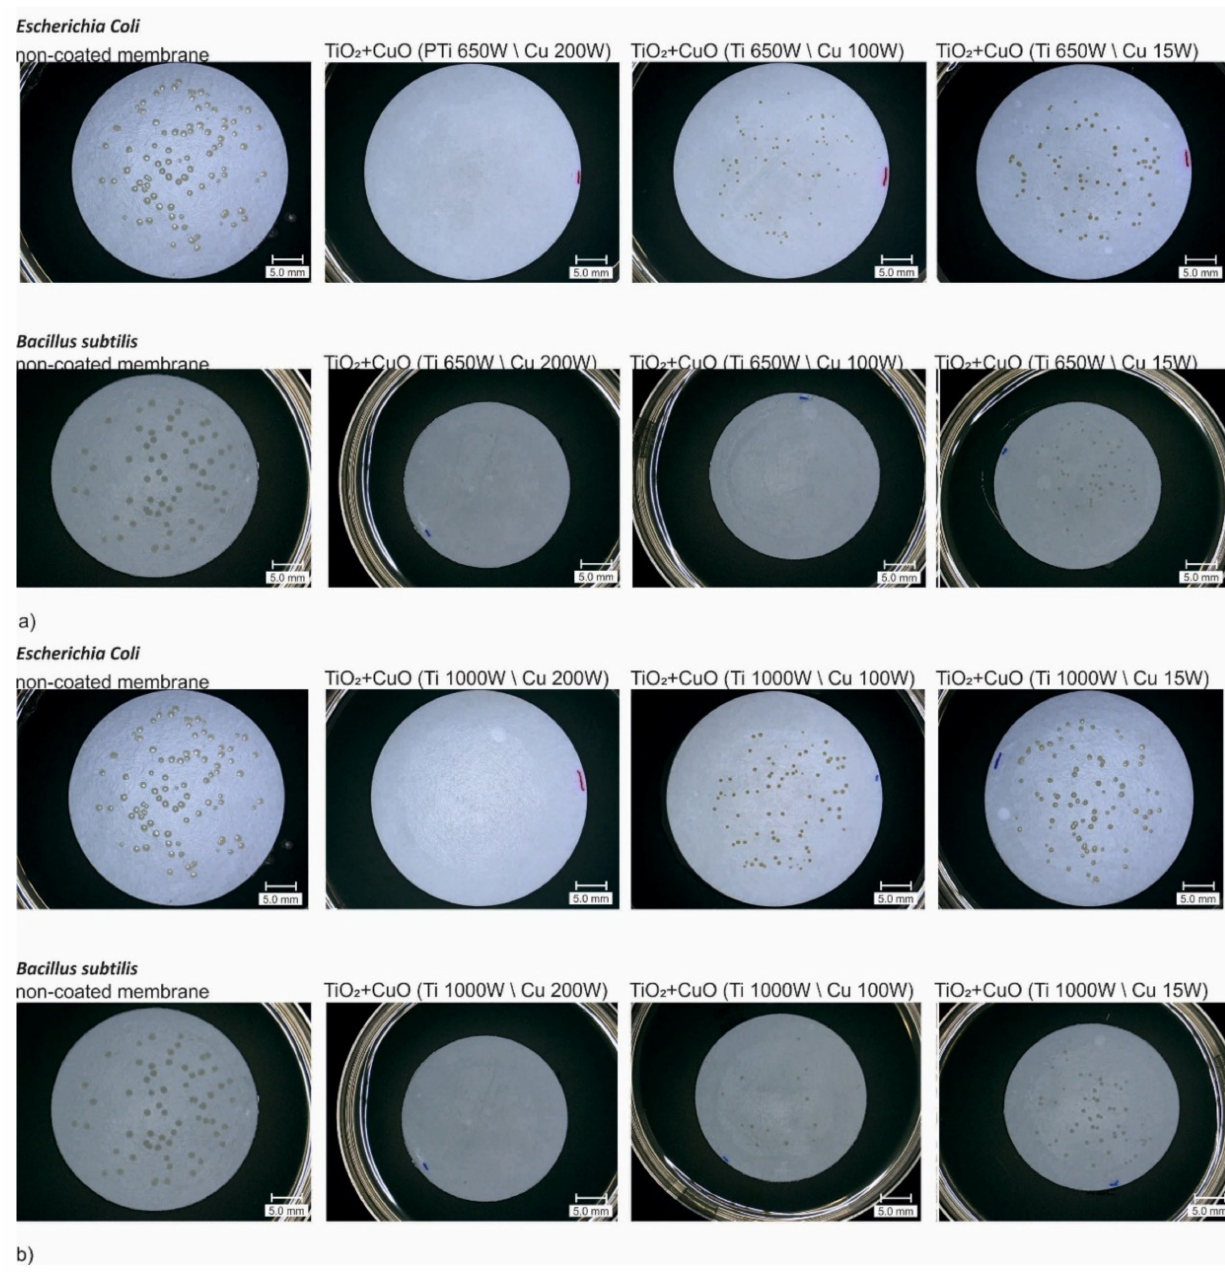
Figure 5. Comparison of 3D microscope images of non-coated membranes and membranes covered with TiO 2 + CuO coat- ings after vacuum filtration of the bacterial suspension: ( a ) P M-Ti = 650 W; P M-Cu = 200 W, 100 W, 15 W; ( b ) P M-Ti = 1000 W; P M-Cu = 200 W, 100 W, 15